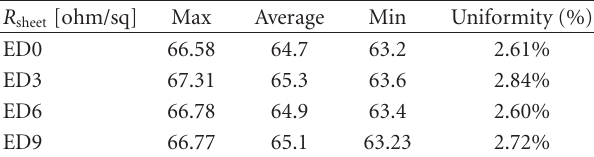
Table 2: R sheet results of di ff erent etching depths after annealing.